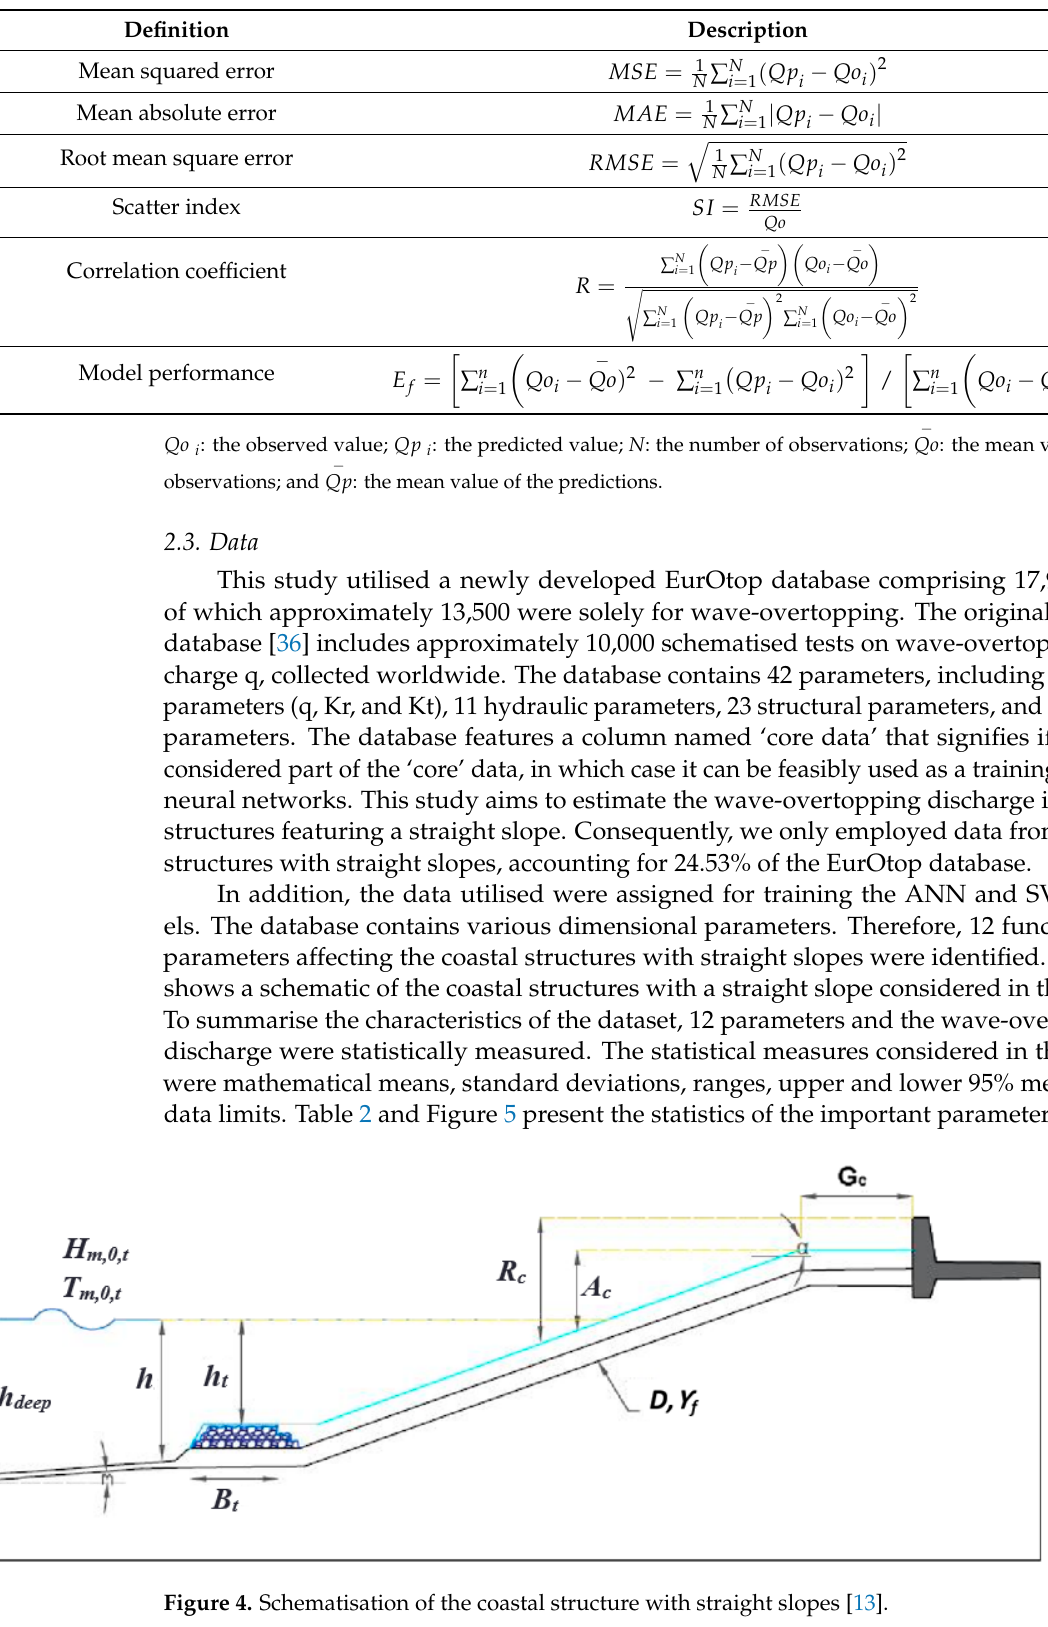
Table 1. Descriptions of the statistical features.